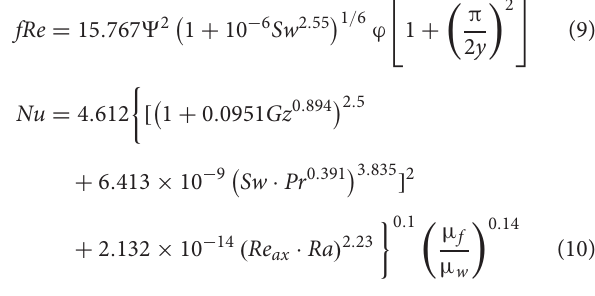
FIGURE 13 | Variation of PEC with the Reynolds number for different fluids in the tube fitted with CCDTT and CCTTT ( y = 3).